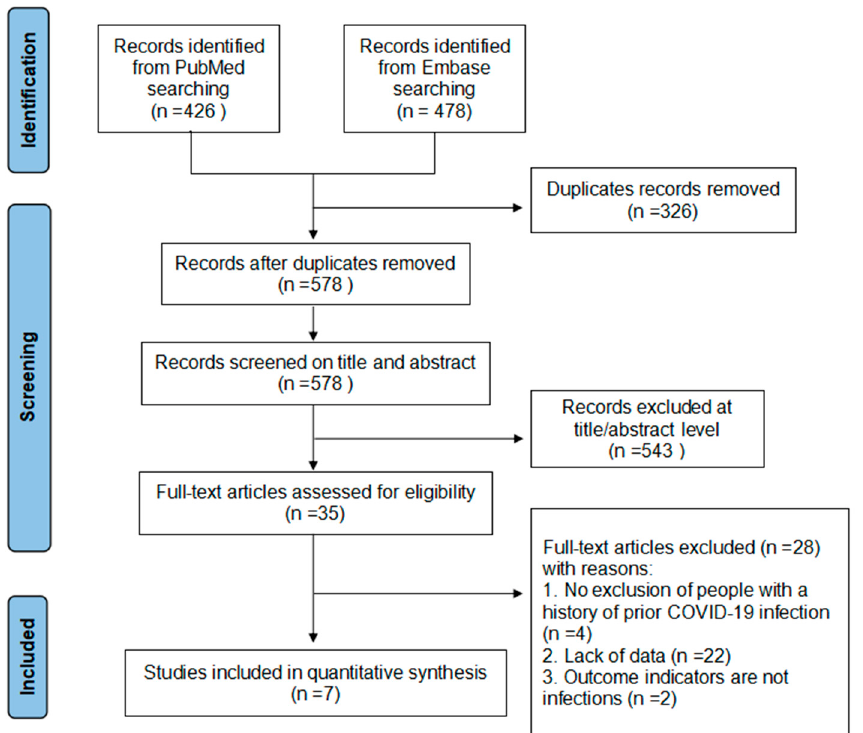
Figure 1. Flow chart of literature search and screening.